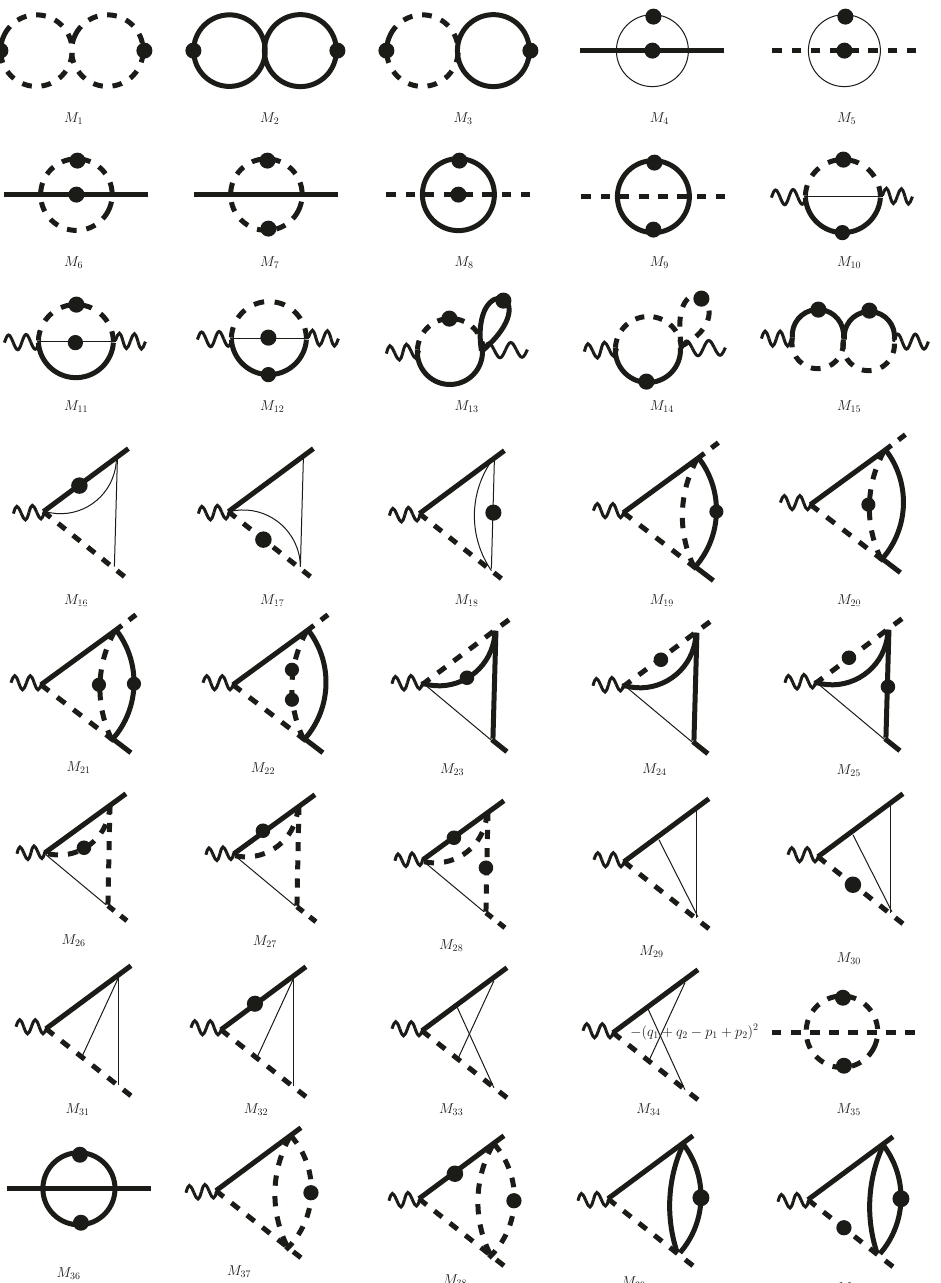
Figure 1 . All the NNLO master integrals for heavy-to-light form factors with di(cid:11)erent type of fermion masses. The thin lines denote massless propagators; the thick dashed lines denote massive fermion with mass m 1 ; and the thick solid lines denote massive fermion with mass m 2 . A dot on a propagator indicates that the power of the propagator is raised to 2. Two dots represents that the propagator is raised to power 3.